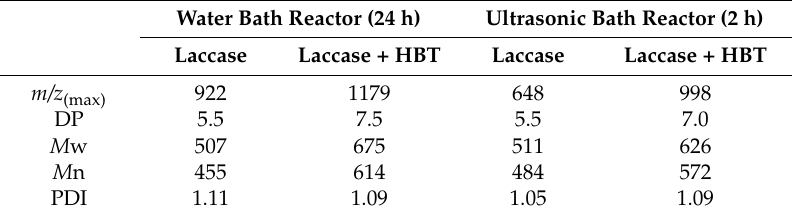
Figure 3. MALDI-TOF (Matrix-Assisted Laser Desorption/Ionization with time-of-flight) of polyaniline obtained by using: ( A1 ) Aniline + laccase + No HBT-water bath for 24 h; ( A2 ) Aniline + laccase + HBT-water bath for 24 h; ( B1 ) Aniline + laccase + No HBT-ultrasonic bath for 2 h; ( B2 ) Aniline + laccase + HBT-ultrasonic bath for 2 h. Table 1. Polyaniline characterization: M n, M w, Polydispersity (PDI), and average polymerization degree (PD) using a water bath and an ultrasonic bath reactors; the values were obtained by MALDI-TOF analysis.